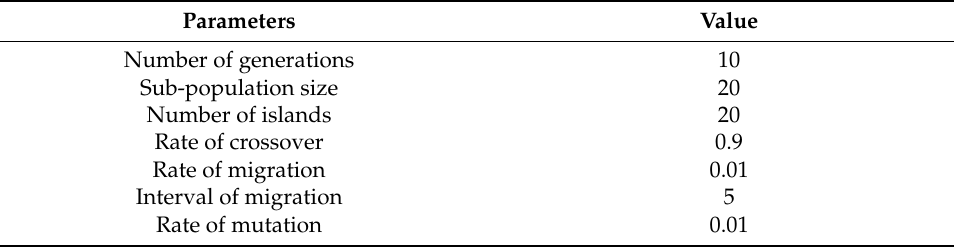
Figure 7. Structure of MIGA. Table 4. Parameters adopted in MIGA.